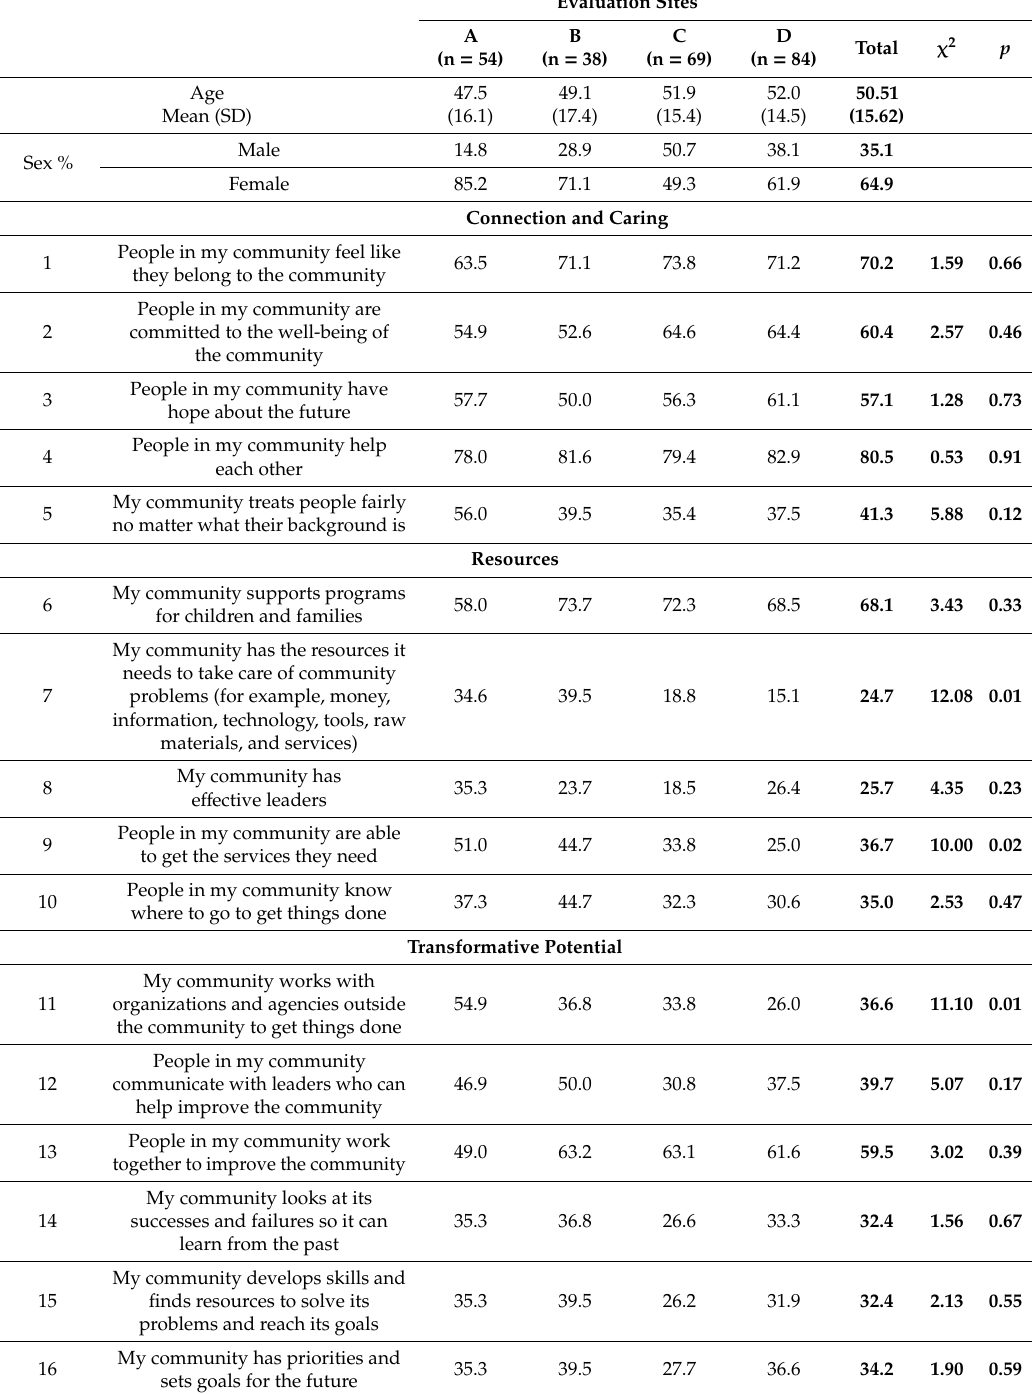
Table 3. Percentage (%) agreement with Communities Advancing Resilience Toolkit (CART) items by study